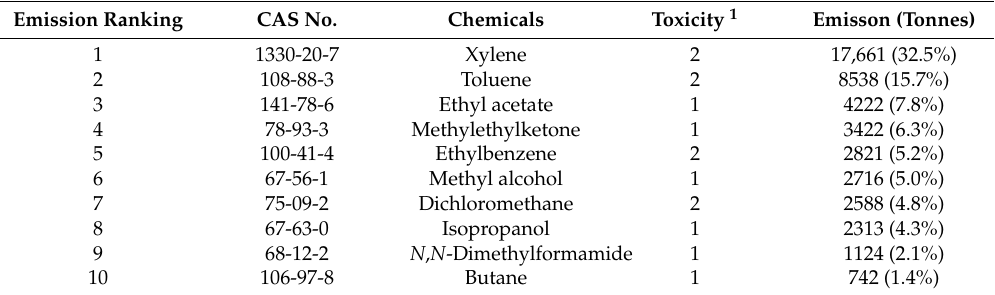
Table 3. Top 10 chemicals released in the Nadong River basin in 2014 (source: [37]). Emission Ranking